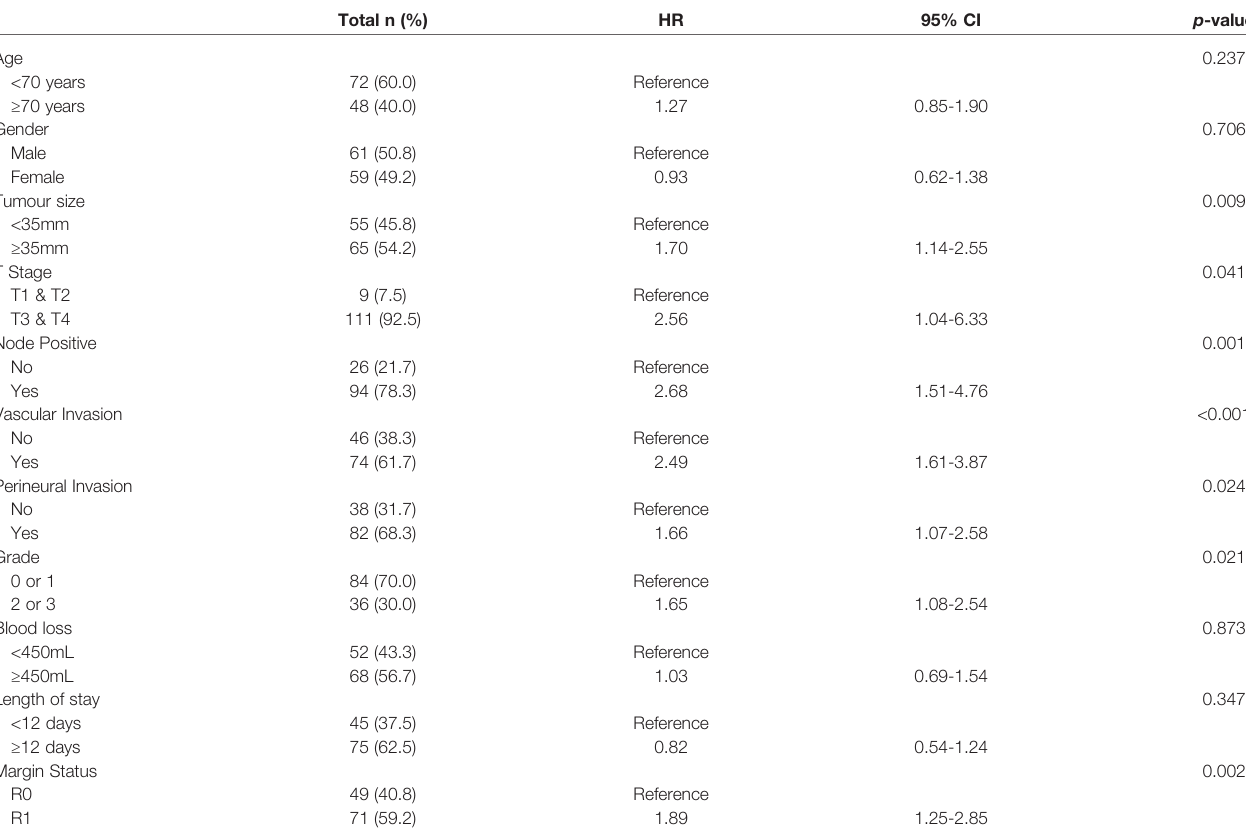
TABLE 1 | Patient and tumour characteristics and correlation with survival status.